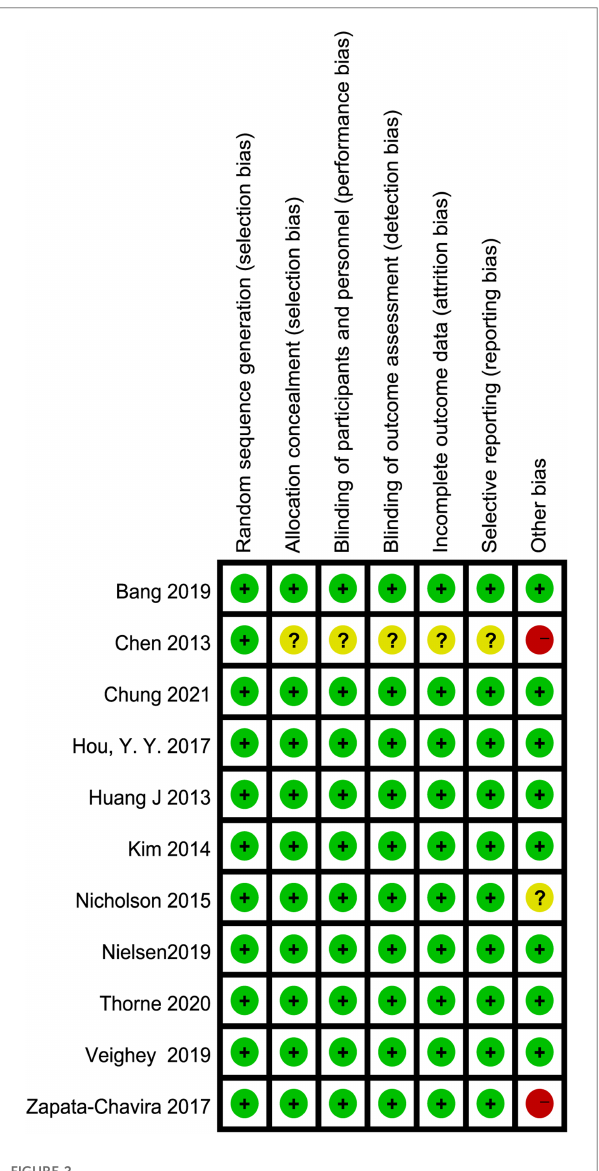
FIGURE 2 Summary of risk of bias: green: low risk of bias, yellow: unclear risk of bias, red: high risk of